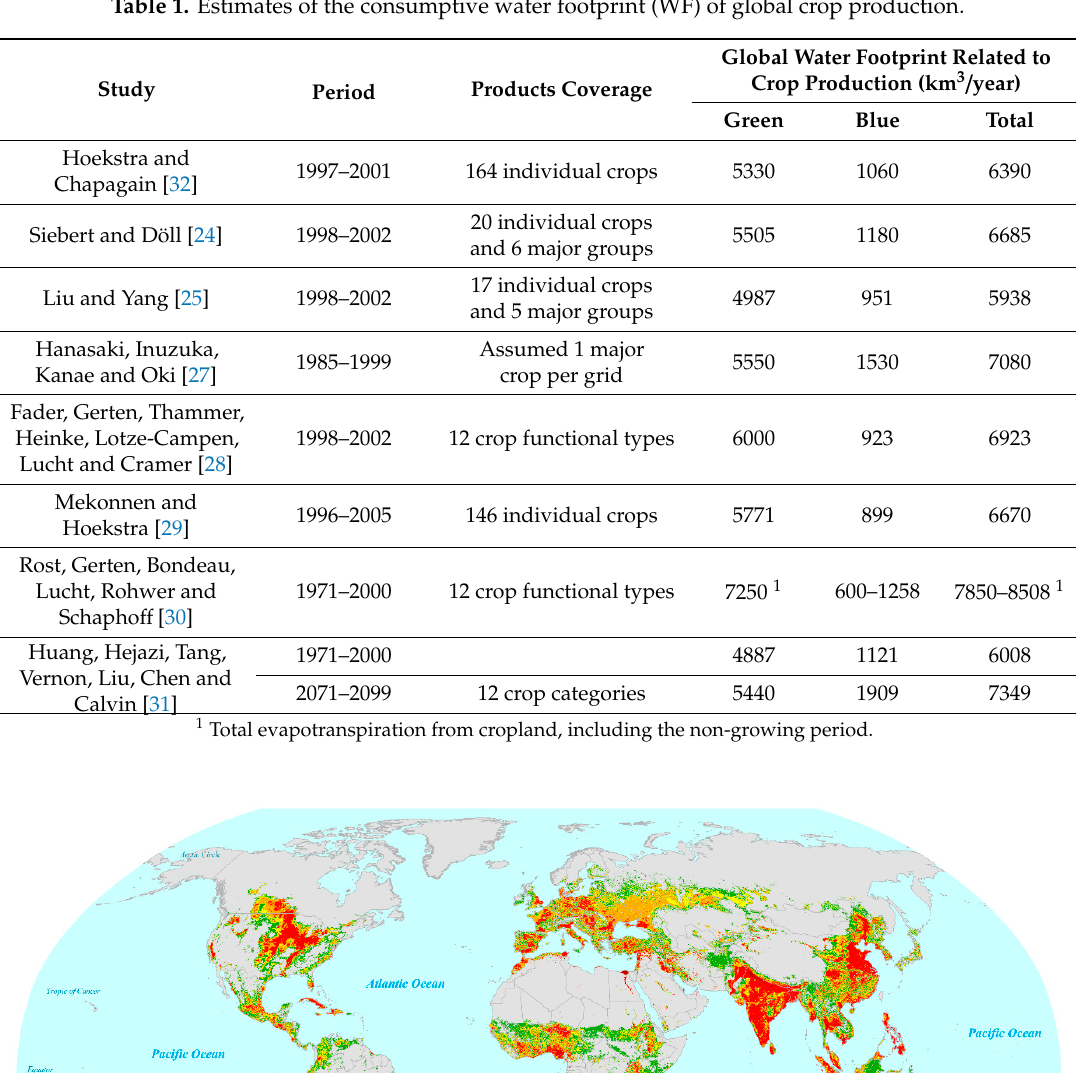
Table 1. Estimates of the consumptive water footprint (WF) of global crop production.